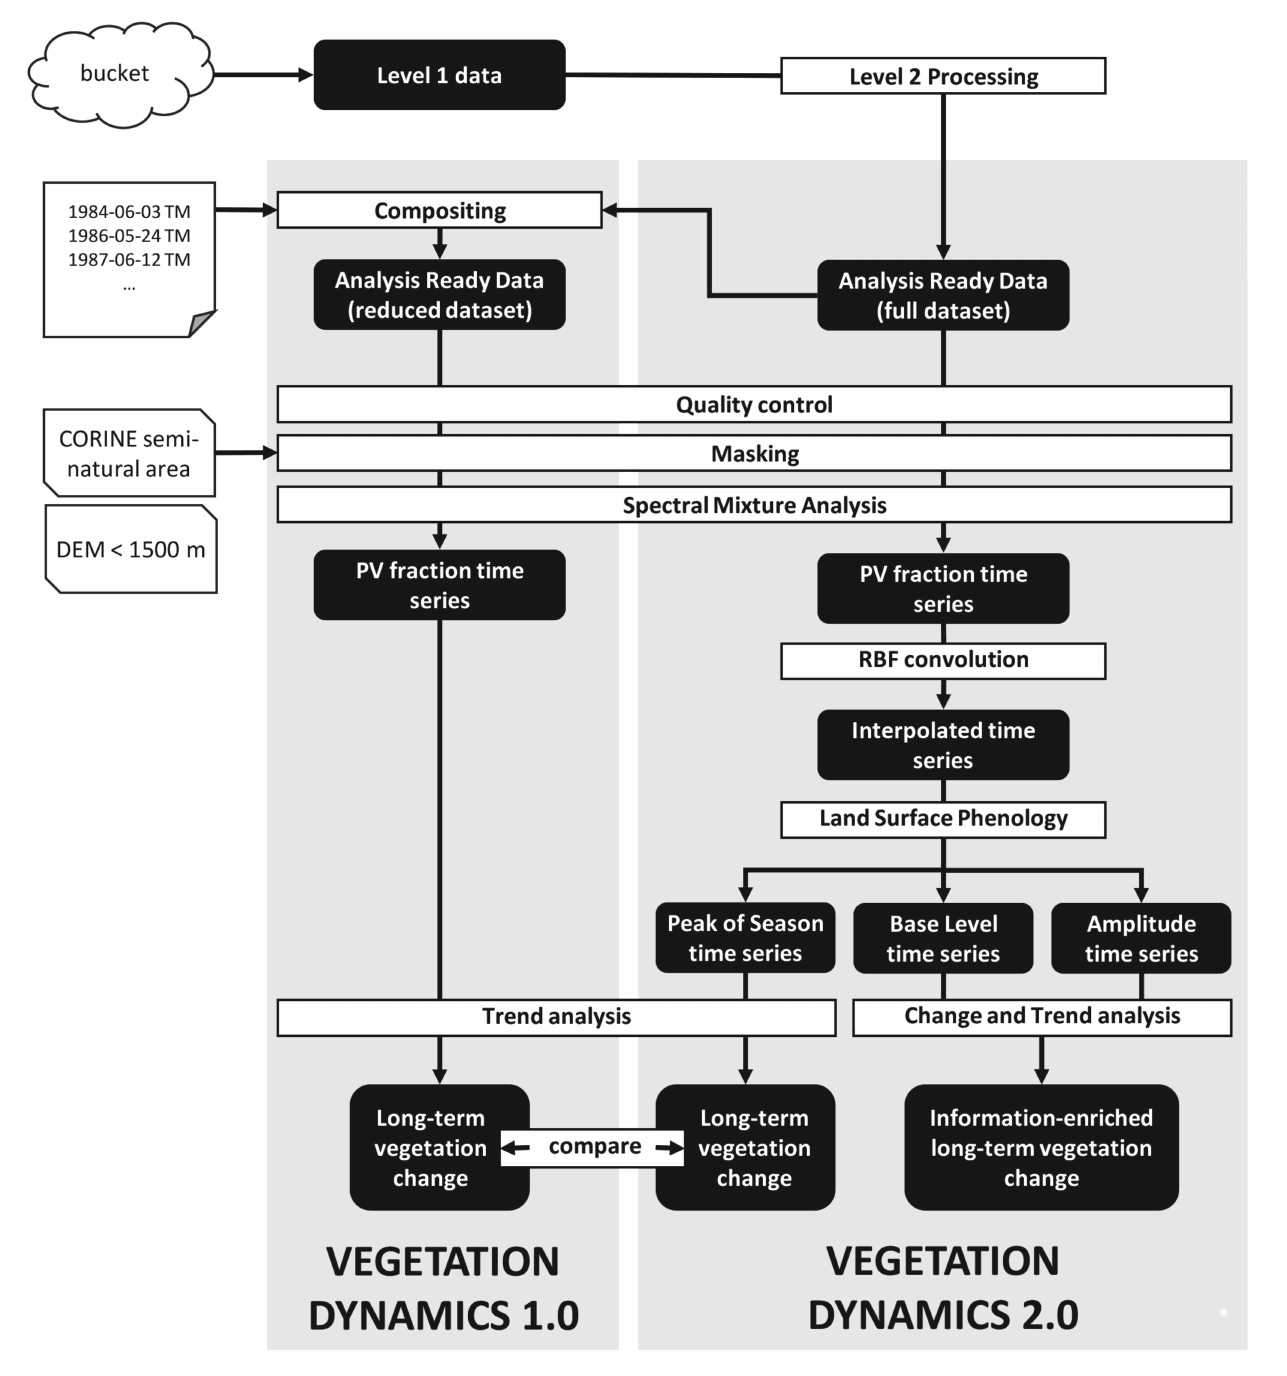
Figure 2. Workflow. Black boxes represent data; white boxes represent processing steps. The dates in the paper symbol represent literature-sourced dates used for generating pixel-based